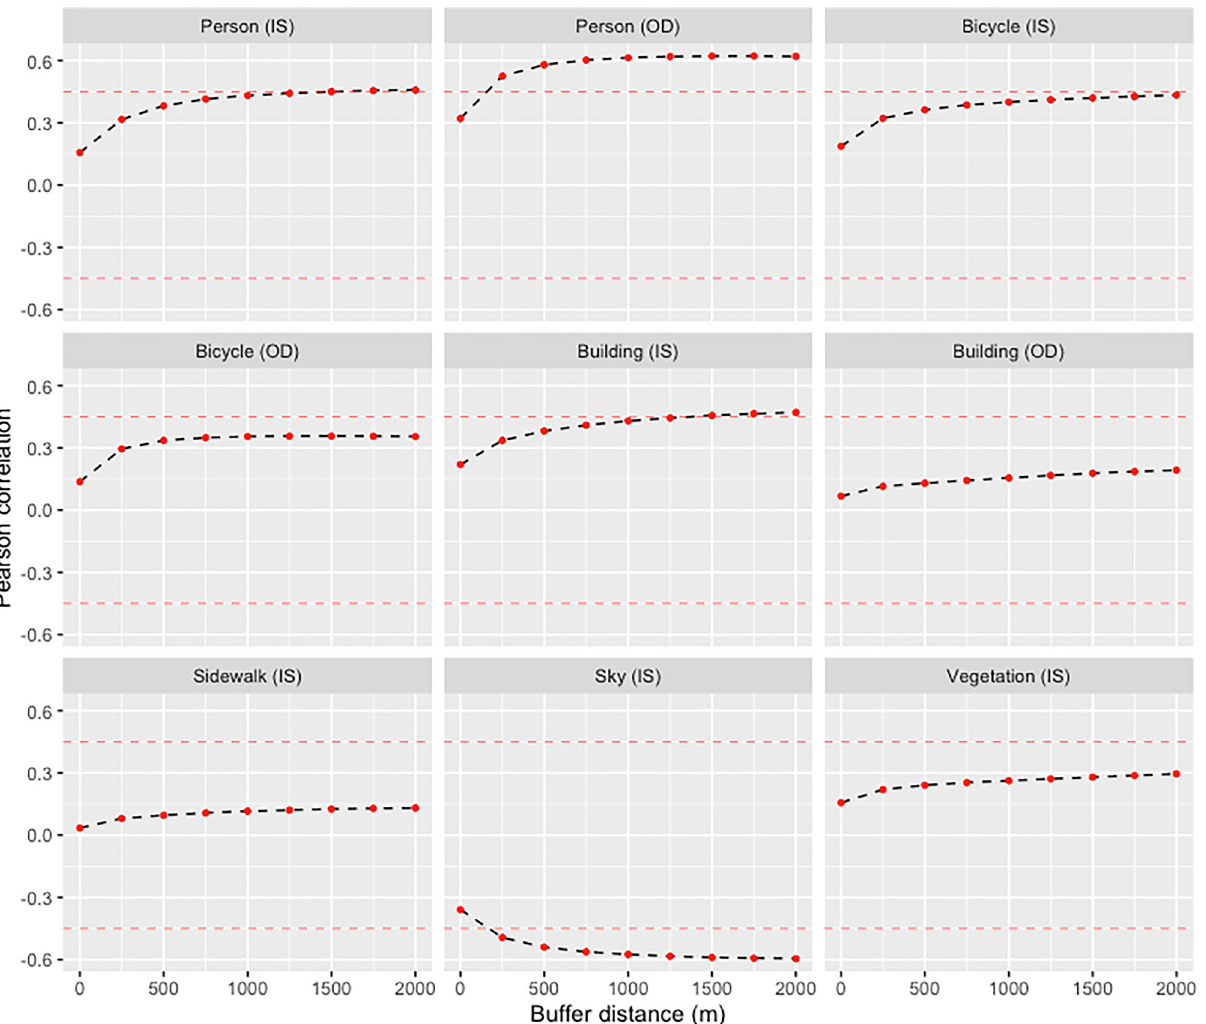
Figure 2. Pearson correlation coefficients for log-transformed walk-to-work rate and pixel coverage (IS) and counts (OD) of different features derived from GSV images within different buffer distances from postal codes*. *Walk-to-work rates are for postal codes with > 0% reported walk commuting. Horizontal dashed lines show > 0.45 and − 0.45 correlation thresholds used to identify variables for inclusion in subsequent regression analyses.